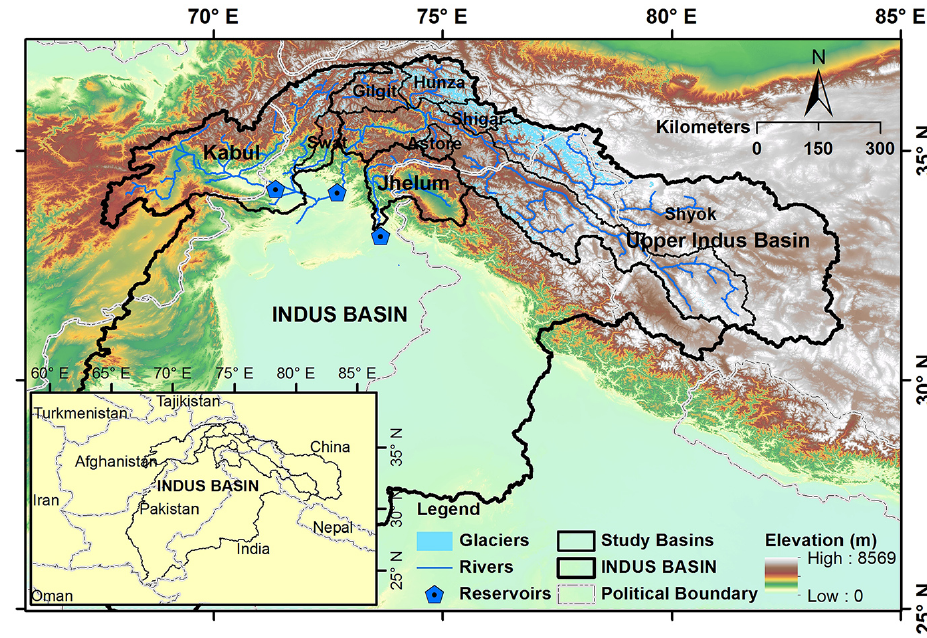
Figure 1. Study area for snow cover mapping showing three major western river basins, namely Indus, Kabul and Jhelum and their six sub-basins. Swat is a sub-basin of the Kabul basin, whereas Gilgit, Hunza, Shigar, Shyok and Astore are the sub-basins of UIB. The political boundaries are tentative.